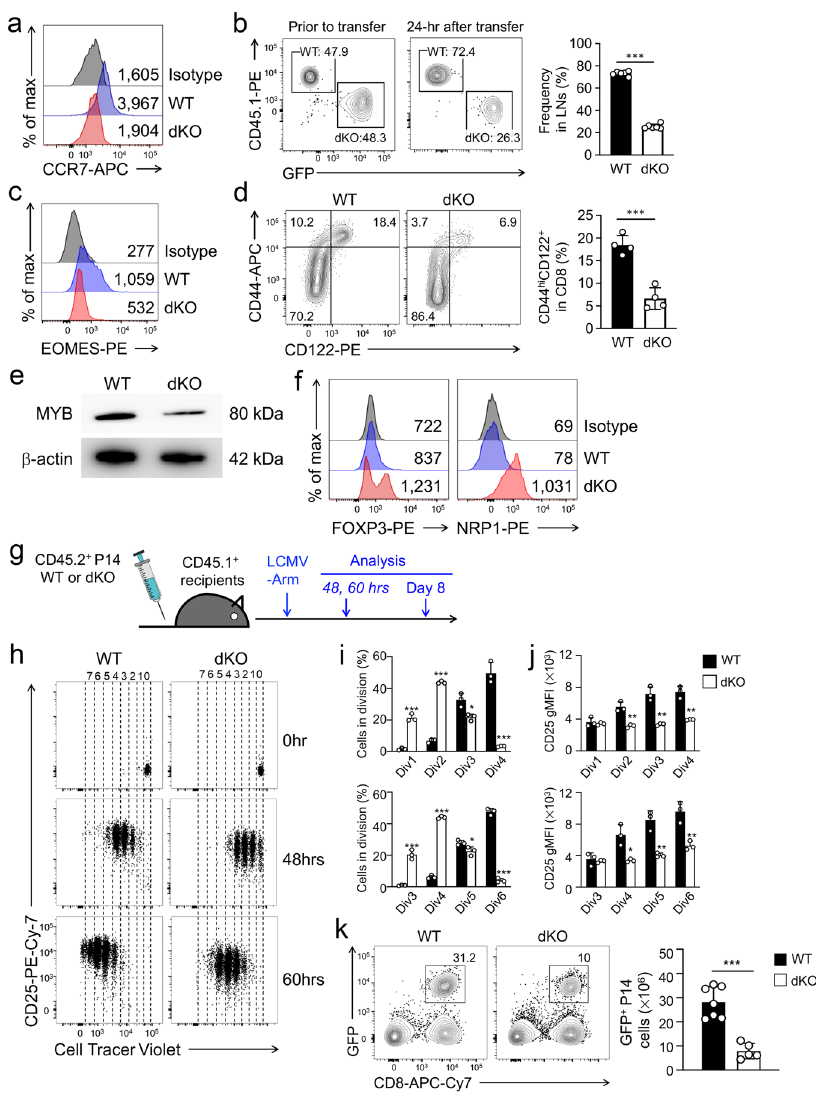
Fig. 9 Tcf1/Lef1 TFs control multiple aspects of mature CD8 + T cell functions. a Detection of CCR7 expression with cell-surface staining. Values denote geometric mean fl uorescent intensity (gMFI). b T cell homing assay. CTV-labeled CD45.1 + WT and CD45.2 + GFP + dKO CD8 + T cells were mixed at 1:1 ratio (left) and transferred into CD45.2 + recipients, and 24 hrs later, donor cells were detected in recipient LNs (right). Cumulative data on donor cell abundance are means ± s.d. from two experiments. c Detection of EOMES expression with intranuclear staining, with gMFI marked. d Detection of memory-phenotype cells in splenic GFP + CD8 + T cells. Cumulative data on the frequency of CD44 hi CD122 + cells are means ± s.d. from two experiments. e , f Detection of MYB expression with immunoblotting ( e ) and FOXP3 and NRP1 expression with fl ow cytometry ( f ). Data are representative from two experiments. g Experimental design for testing CD8 + T cell activation and differentiation in vivo. h – j Detection of CD8 + T cell division and CD25 induction during the fi rst 60 hrs of activation. CTV-labeled splenic CD8 + T cells were transferred into CD45.1 + hosts followed by LCMV-Armstrong infection. CTV dilution and CD25 expression were monitored before (0 hrs), 48 or 60 hrs after infection in recipient spleens. h representative dot plots where dotted lines mark cells in different divisions. i Cumulative data on the frequency of cells in indicated cell divisions at 48 (top) and 60 hrs (bottom) post infection. j . Cumulative data on CD25 gMFI in cells at different dividing stages at 48 (top) and 60 hrs (bottom) post infection. Data are means±s.d. from two experiments. k Detection of effector P14 CD8 + T cells on day 8 post infection. Effector P14 cells were detected as GFP + CD8 + T cells in recipient spleens, with values in representative contour plots denoting cell frequency. Cumulative data on effector P14 cell counts are means±s.d. from two experiments. Statistical signi fi cance for ( b , d , i and k ) was assessed with two-tailed Student ’ s t -test. *, p <0.05; **, p <0.01; ***, p